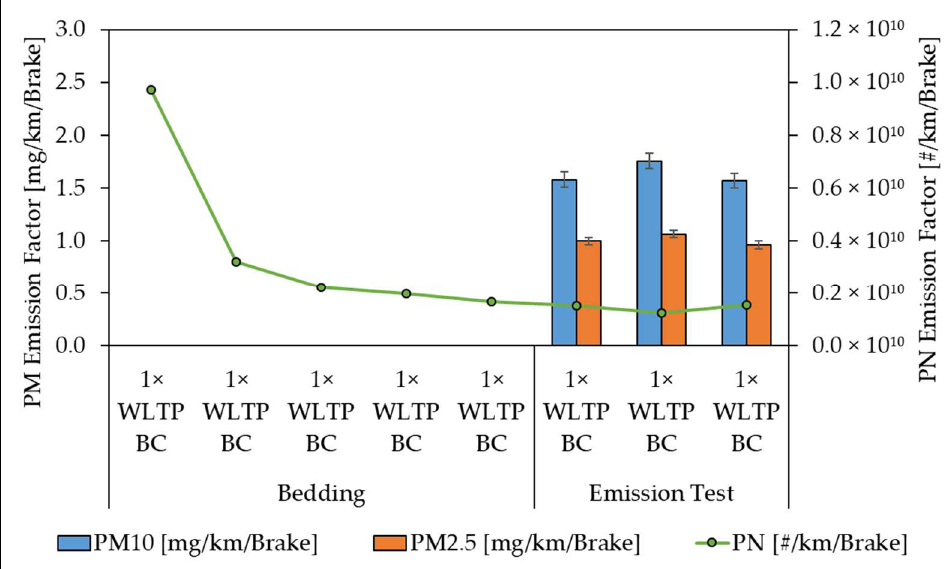
Figure 19. Emission factors of the HMC friction pairing in the course of measurements.